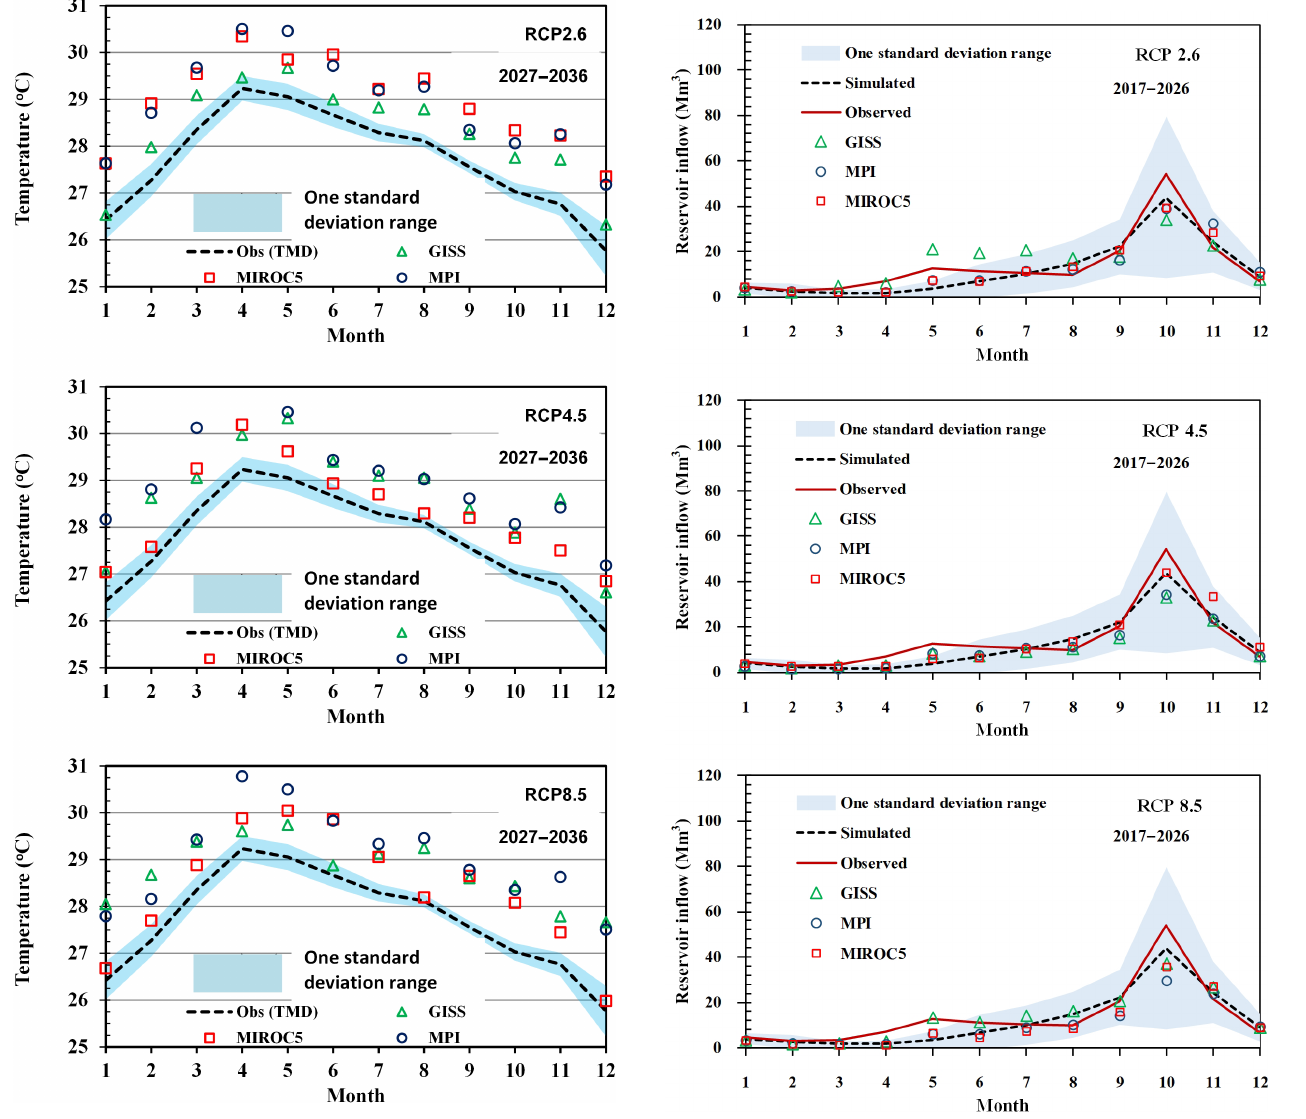
Figure 8. Projected mean monthly reservoir inflows under 3 sce- narios for the years 2017–2026 at Dok Krai